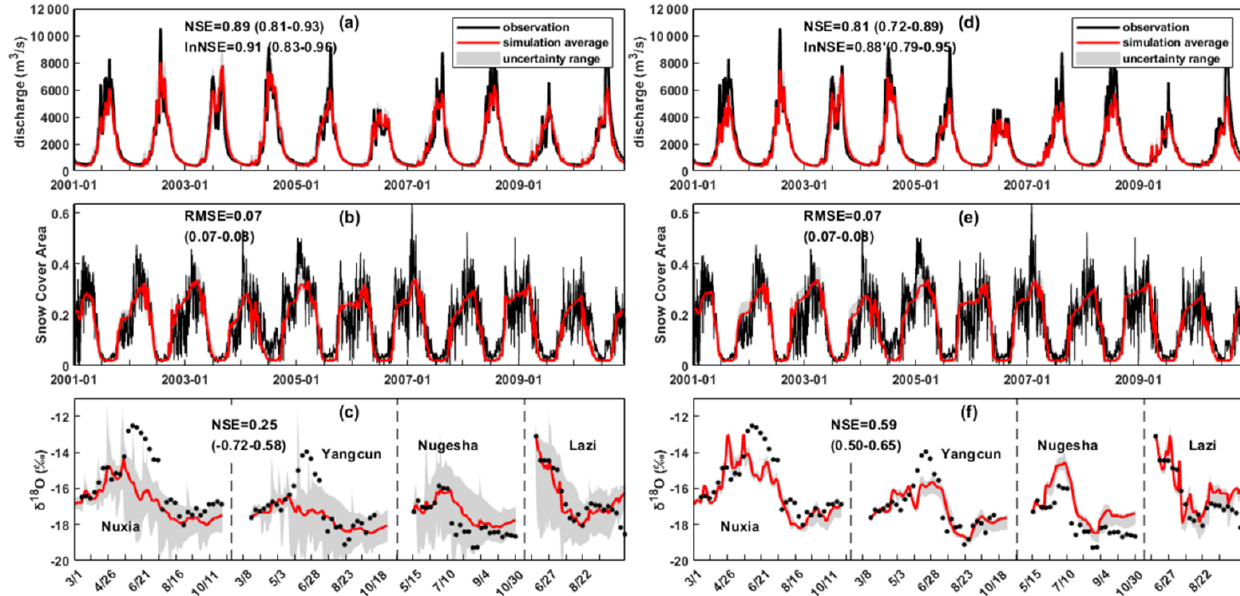
Figure 2. Uncertainty ranges and metrics values of the simulated discharge (Nuxia station), SCA, and stream δ 18 O (at four stations dur- ing 2005) in the YTR basin, that were produced by the behavioral parameter sets of a bi-objective calibration (a–c) and a tri-objective (d–f) calibration in the benchmark model